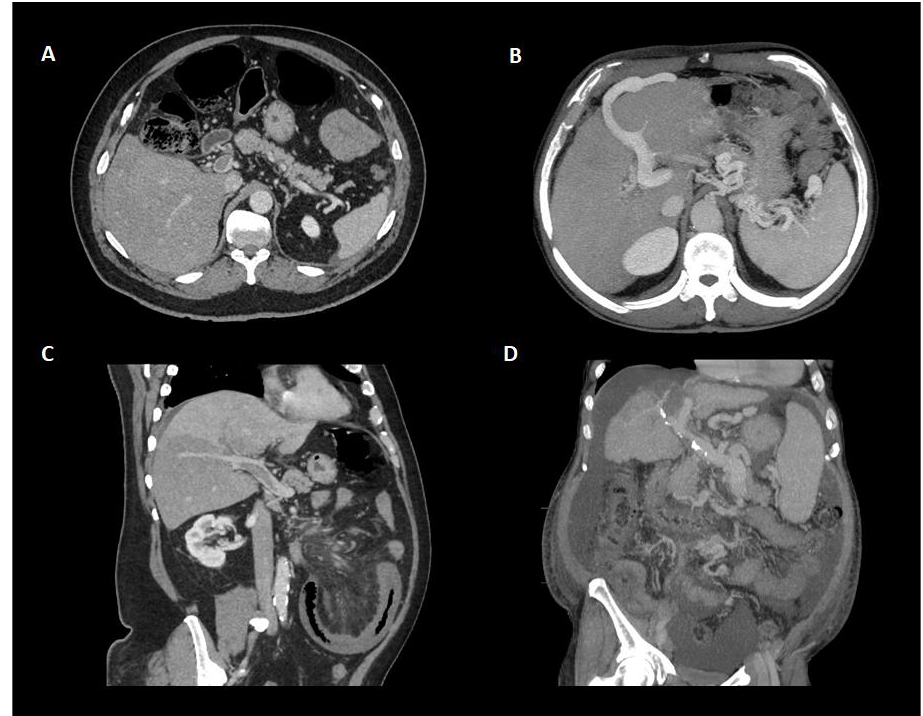
Figure 3. Different presentations of portal vein thrombosis through contrast-enhanced CT scan. ( A ) Axial plane showing a partially occlusive portal vein thrombosis of the main portal trunk without collaterals or other indirect signs of portal hypertension. ( B ) Apparition of collateral circulation with umbilical vein repermeabilization and enlarged spleen in the context of portal vein thrombosis. ( C ) Oblique plane showing a partially occlusive portal vein thrombosis of the main portal trunk with hepatic perfusion defects on the lower segments of the right lobe. ( D ) Chronic portal vein thrombosis in patient with cirrhosis. Note the calcification of the portal vein as an indirect sign of chronicity. Atrophic liver with splenomegaly, collaterals, and ascites are found in the context of cirrhosis.